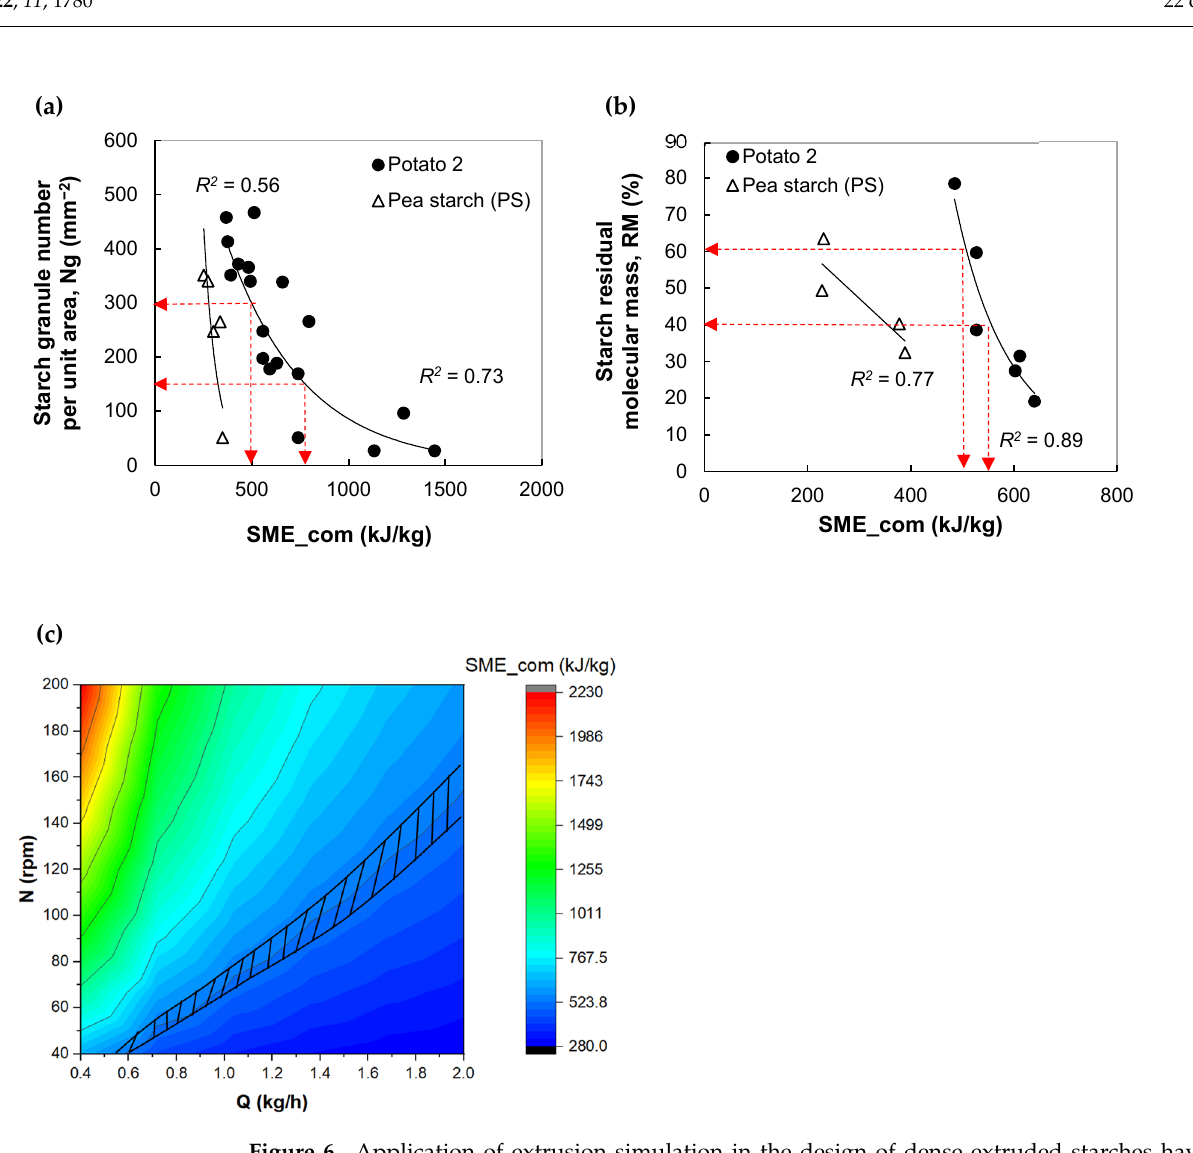
Figure 6. Application of extrusion simulation in the design of dense extruded starches having targeted starch transformation. Step 1. Variation of the remnant granule number per unit area (Ng) Figure 6. ( a ) and residual molecular mass (RM) ( b ) with SME_com. The arrows indicate lower and upper limits of targeted SME_com, Ng, and RM. Step 2. Creation of extruder operating chart by the 1D extrusion model and determination of the range of extrusion conditions (Q, N), delimited with a hatched area, leading to SME_com between 500 and 550 kJ/kg according to the goal: RM = 50 ± 10% and 150 ≤ Ng ≤ 300 ( c ). Fixed conditions: MC = 30%, last barrel temperature = die temperature = 95 ◦